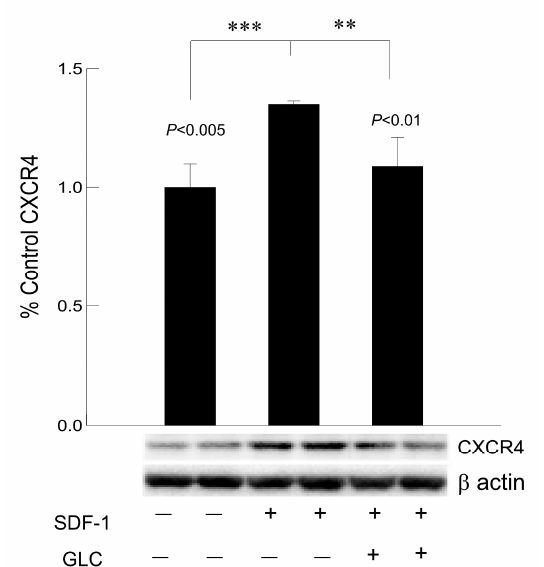
Figure 8. Hyperglycemia mediated increased expression of chemokine receptor CXCR4 was mim- icked by SDF1 and treatment with GLC could block the effect in cardiomyocytes in vitro. Treatment with CXCR4 agonist, SDF1 showed increased expression of CXCR4 in cardiomyocyte (CM) cells in vitro (*** p < 0.005). CM cells were treated with GLC for 24 h showed reduction in CXCR4 expression when pre-treated with SDF1 (** p < 0.01).